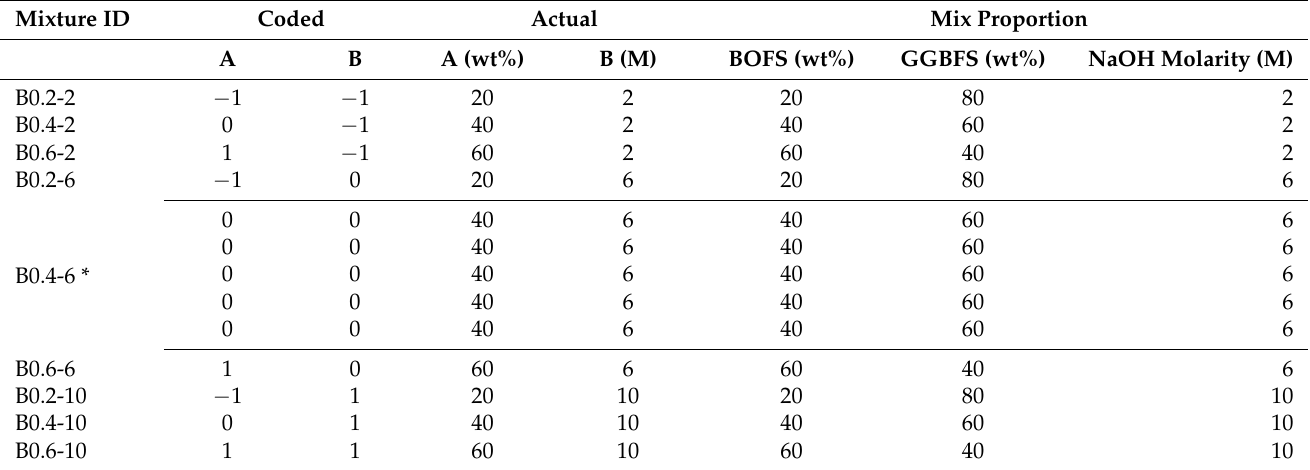
Table 3. Details of experimental mix